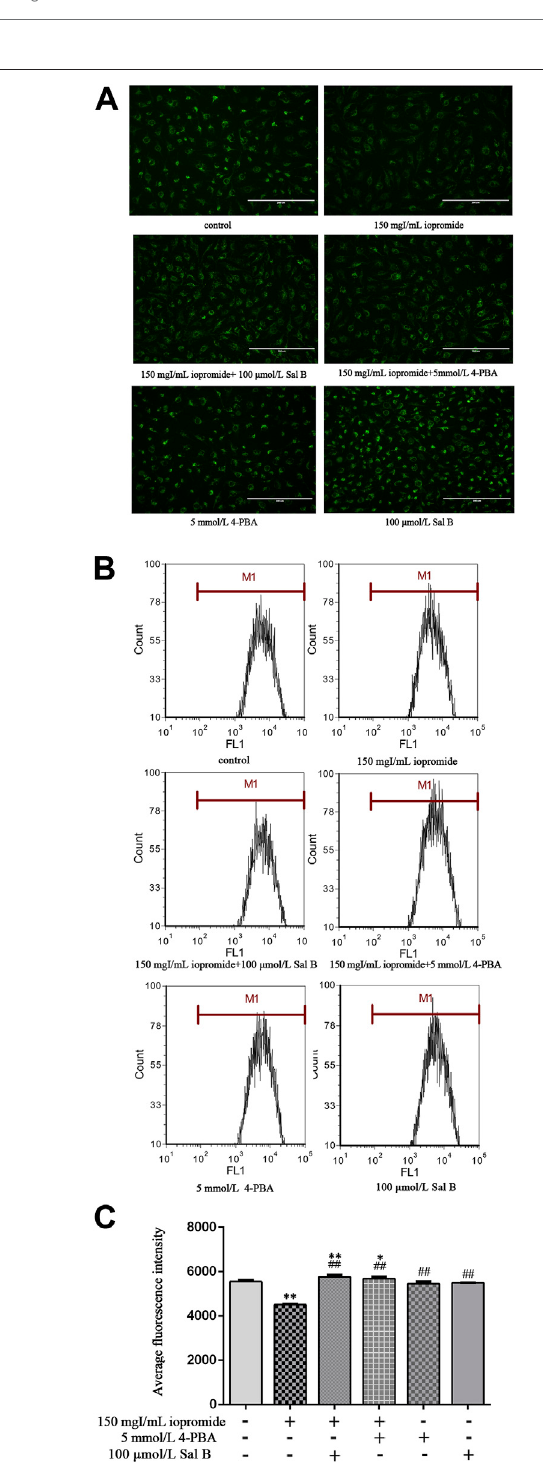
FIGURE 4 | Effect of Sal B or 4-PBA in iopromide-induced loss of the MMP. (A) The green fl uorescence (readout of MMP) in the iopromide-treated cells was lower than in the control cells. However, Sal B or 4-PBA increased the fl uorescence, indicating that they played a protective role by maintaining and/or restoring the MMP. (B, C) Similar results were obtained by fl ow cytometry. The data were determined by ANOVA and LSD post-hoc test and are presented as the mean ± SD ( n (cid:1) 3). * P < 0.05, ** P < 0.01 vs. control group; ## P < 0.01 vs. iopromide group.